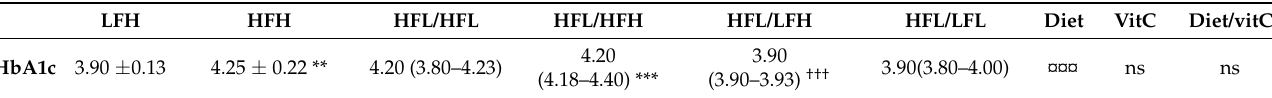
Table 1. HbA1c plasma levels in all groups at week